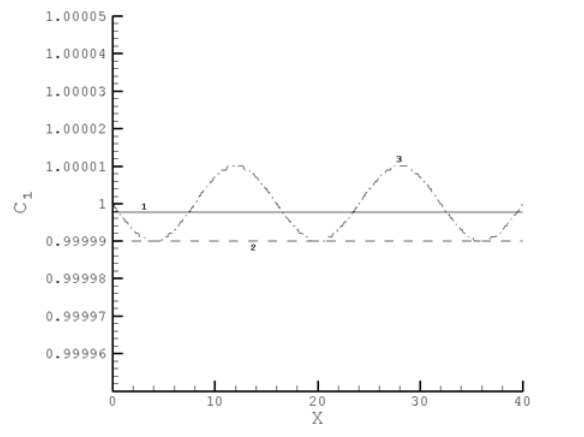
Fig. 2. The final distribution of the cation K + concentration for different types of perturbations with the flow velocity u=0.25 . 1: Electroneutral perturbation; 2: Non-electroneutral constant perturbation; 3: Non-electroneutral sinusoidal perturbation.